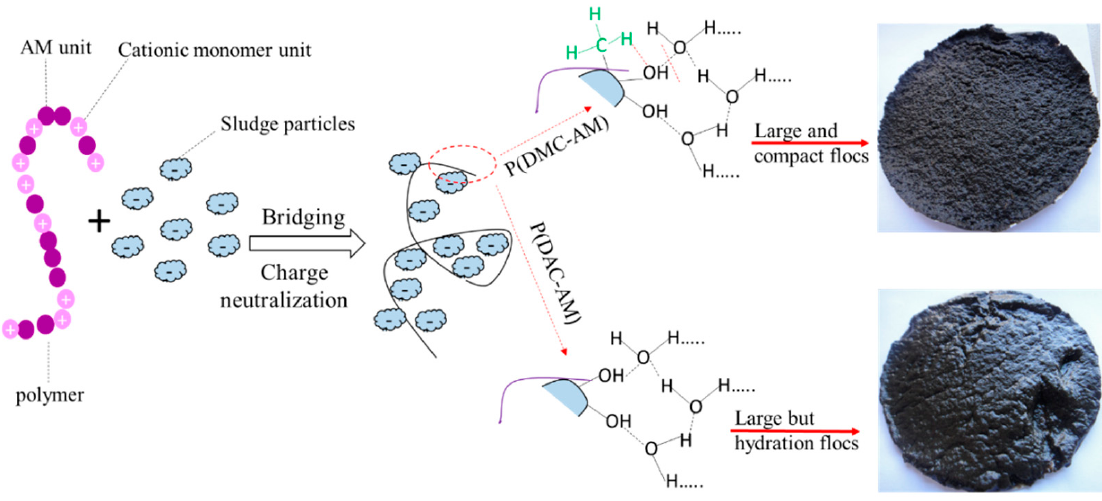
Figure 8. Possible flocculation mechanism of P(DMC ‐ AM) and P(DAC ‐ AM) [92].